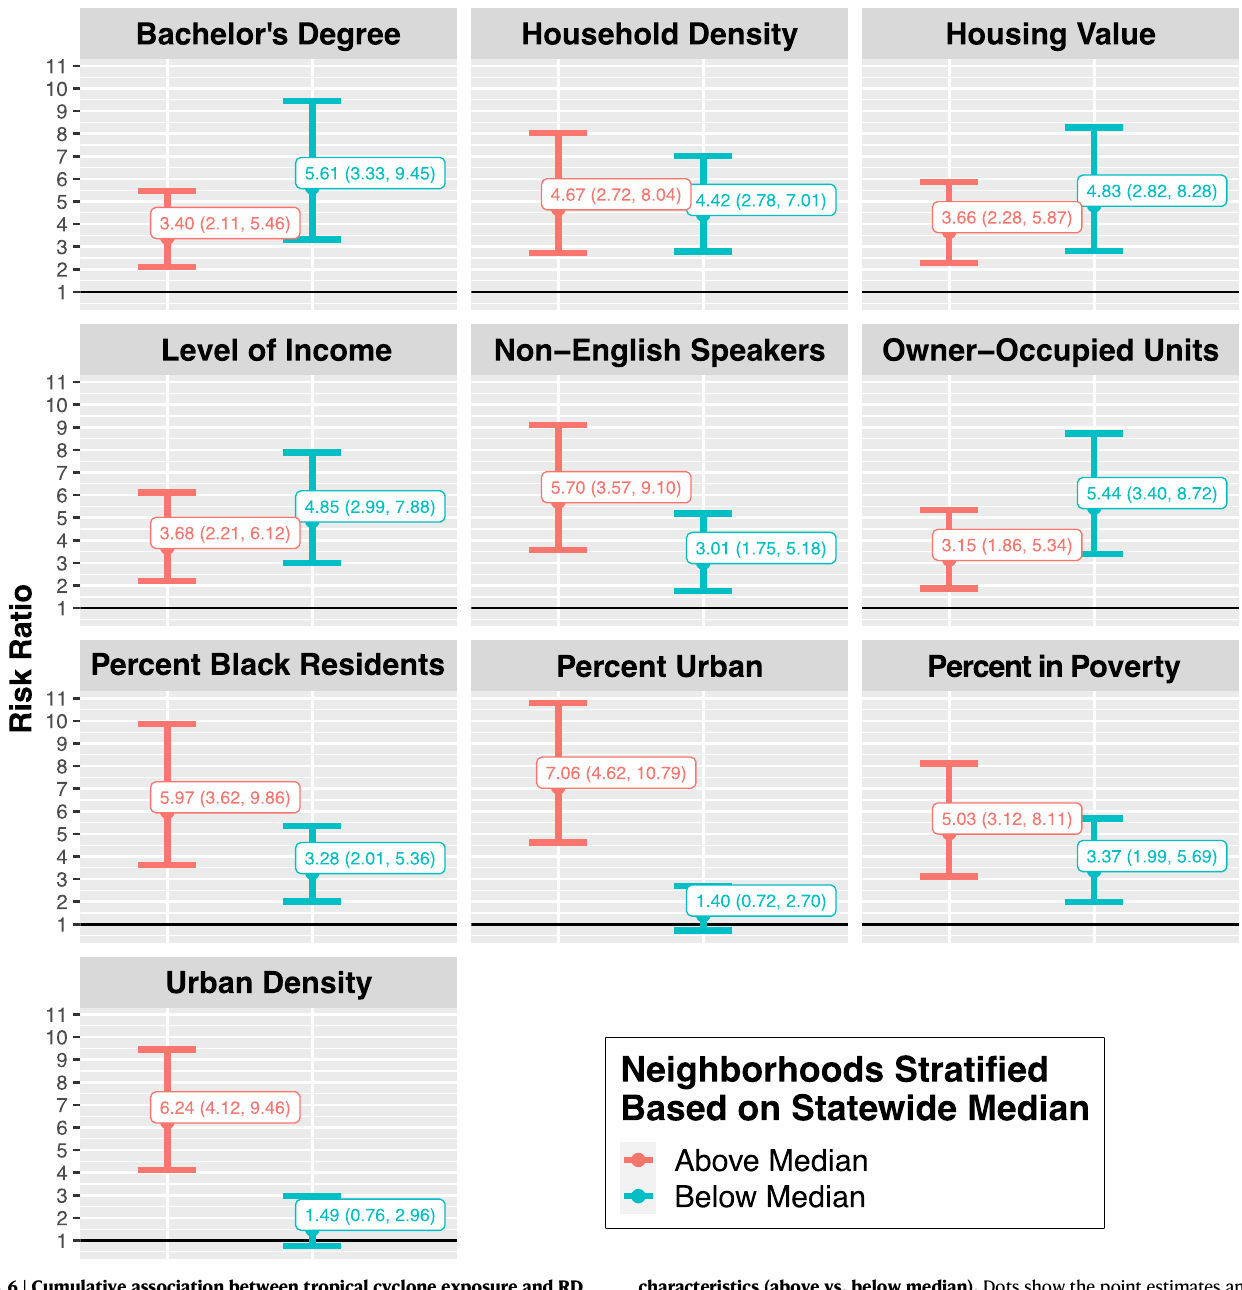
Fig. 6 | Cumulative association between tropical cyclone exposure and RD hospitalization risk in Florida ZCTAs ( n =796) from 1999 to 2016, from 2 days before to 7 days after a storm day, strati fi ed by neighborhood-level